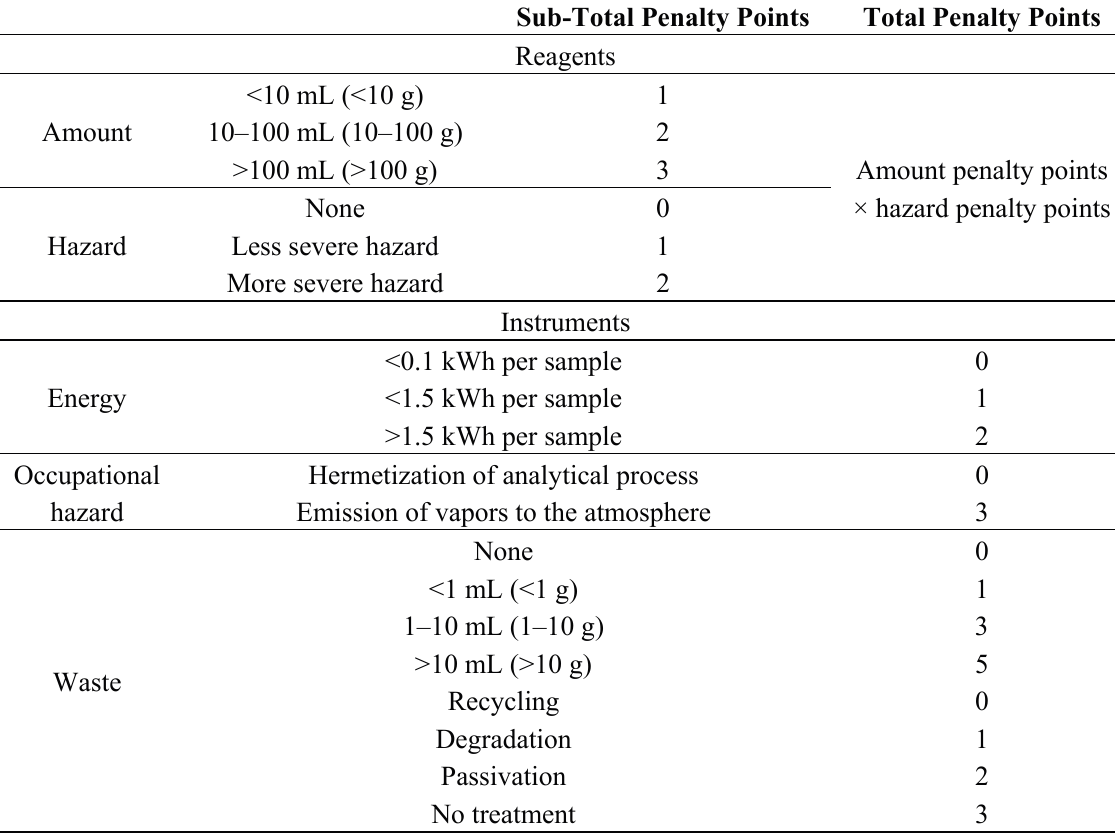
Table 3. Penalty points applied for the calculation of final analytical Eco-Scale